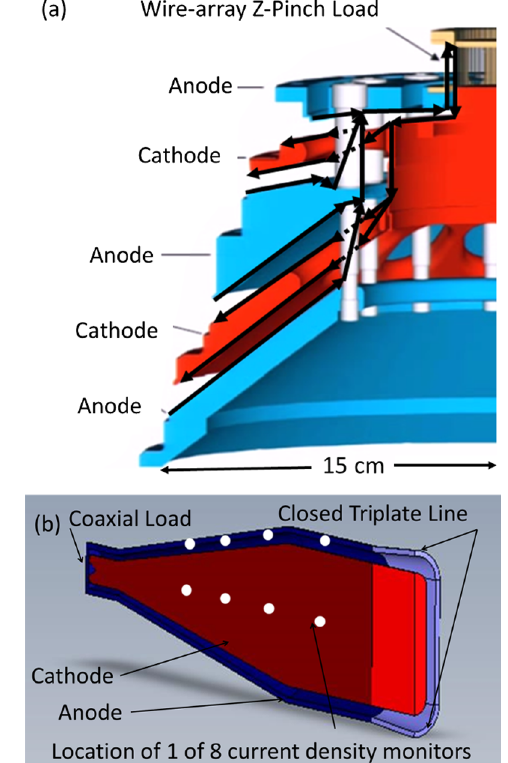
FIG. 1. (a) Quarter cross-sectioned view of a double PHC with 12-fold azimuthal symmetry. The currents from double biconic MITLs are combined to power the common z -pinch load on the Z Machine at Sandia National Labs. The three-dimensional com- plexity is evident from the arrows, which show the current path from the anodes to the cathodes; dotted lines indicate flow through the cathode behind the anode post. (b) Cross-sectioned view of the simpler, MITE tapered convolute, as seen in a cutaway view, through the vertical plane of